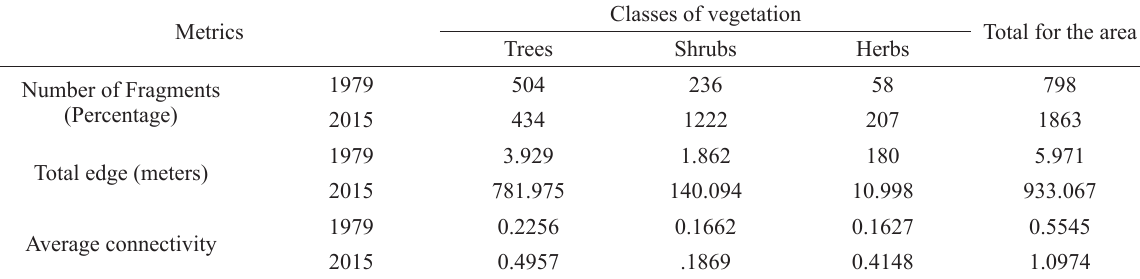
Vegetation classes and the metrics of “number of fragments”, “total edges” and “connectivity” for the fragmented area in the municipality of Conceição do Mato Dentro (Minas Gerais) for the years of 1979 and 2015. Metrics